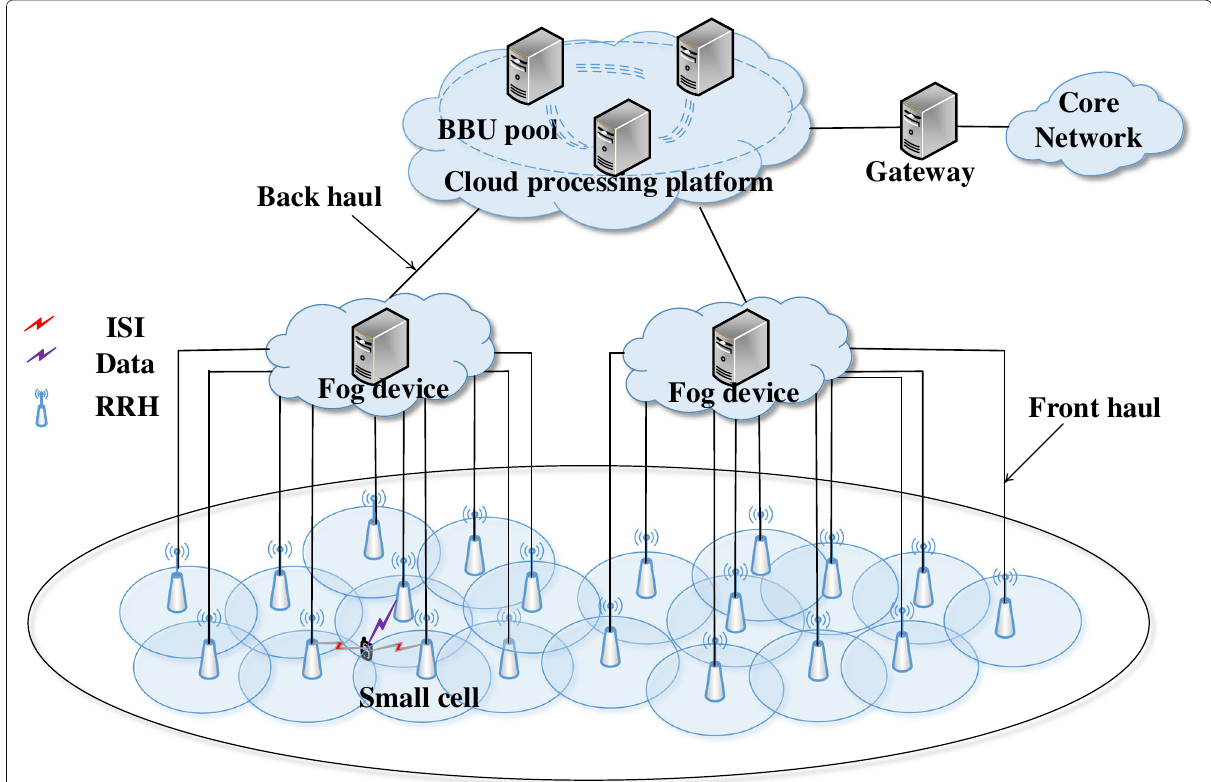
Fig. 1 System network